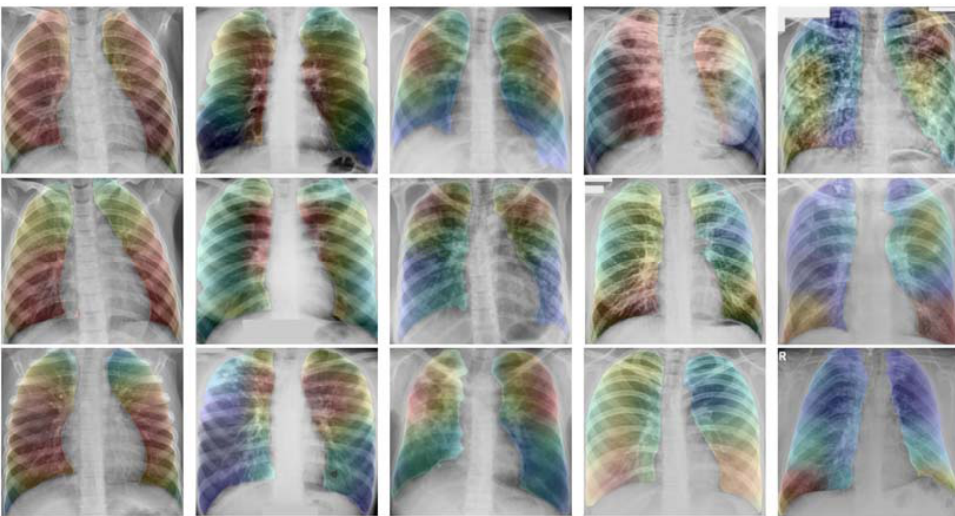
Figure 3. GradCAM visualizations on X ‐ ray images.